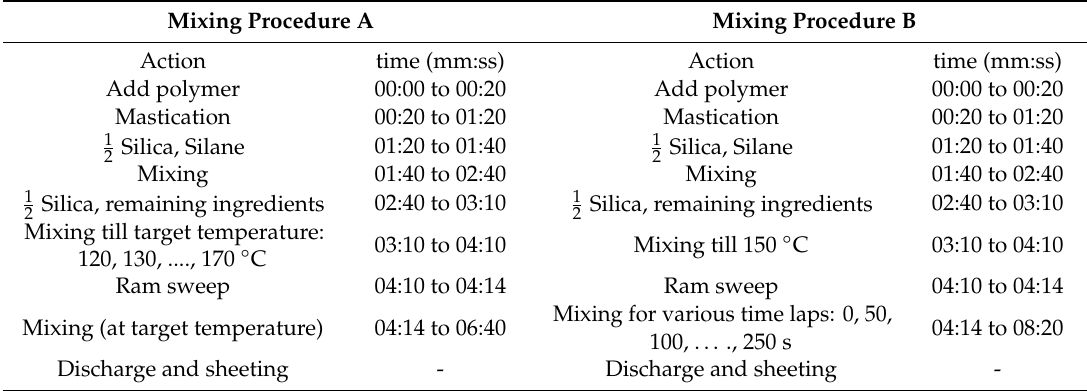
Table 2. Master batch mixing procedure.